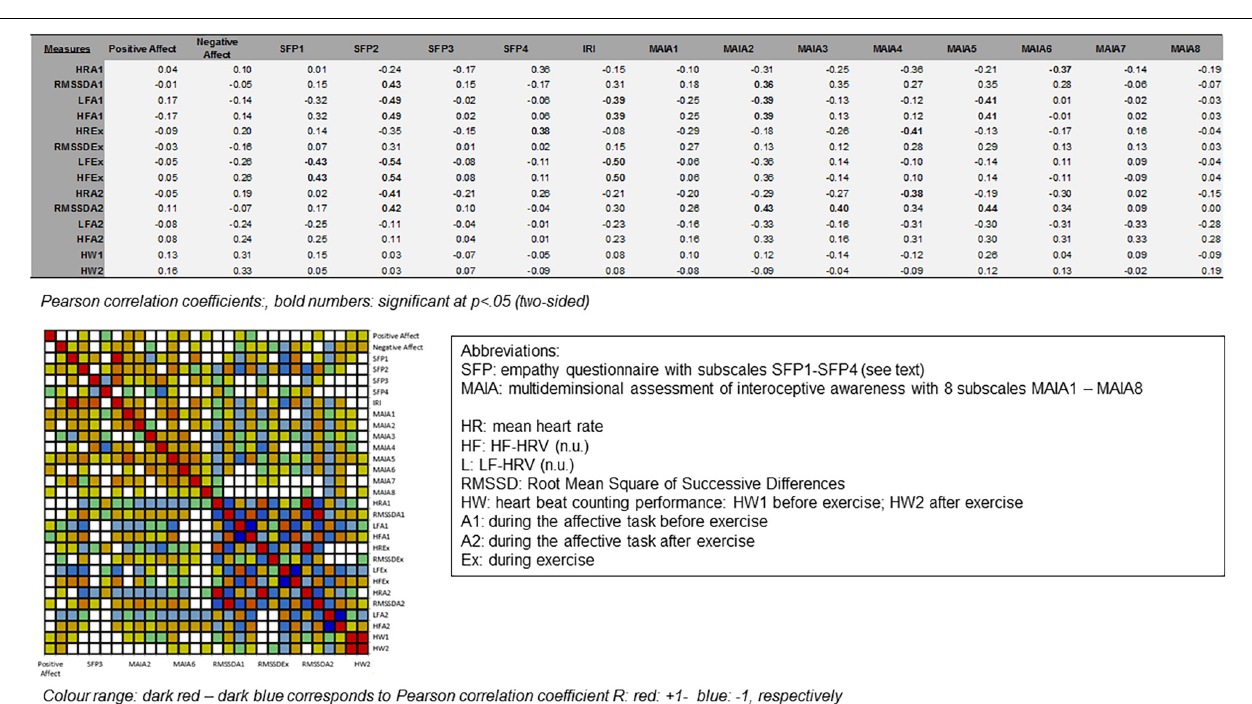
FIGURE 7 | Correlation analyses. Plots and tables. For details, see